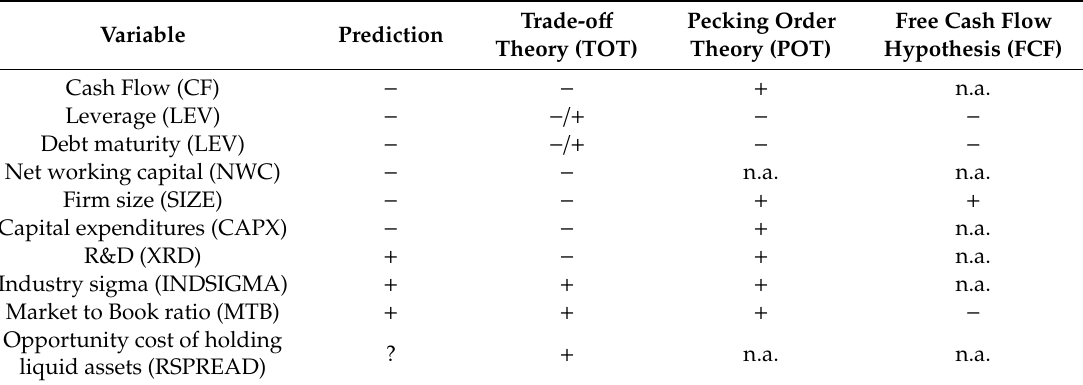
Table 1. Summary of model